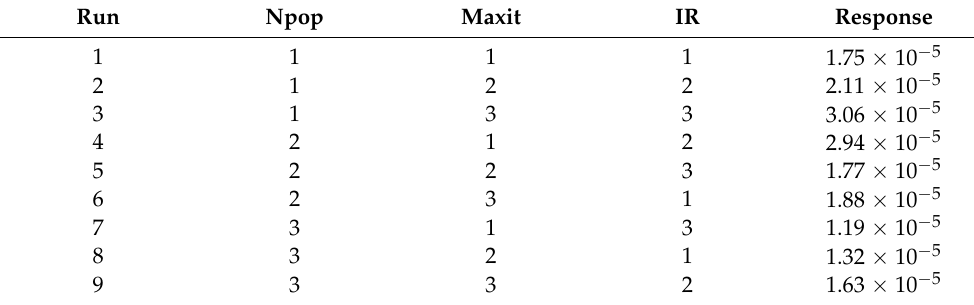
Table A8. The orthogonal array L9 and computational results for MOGWO.